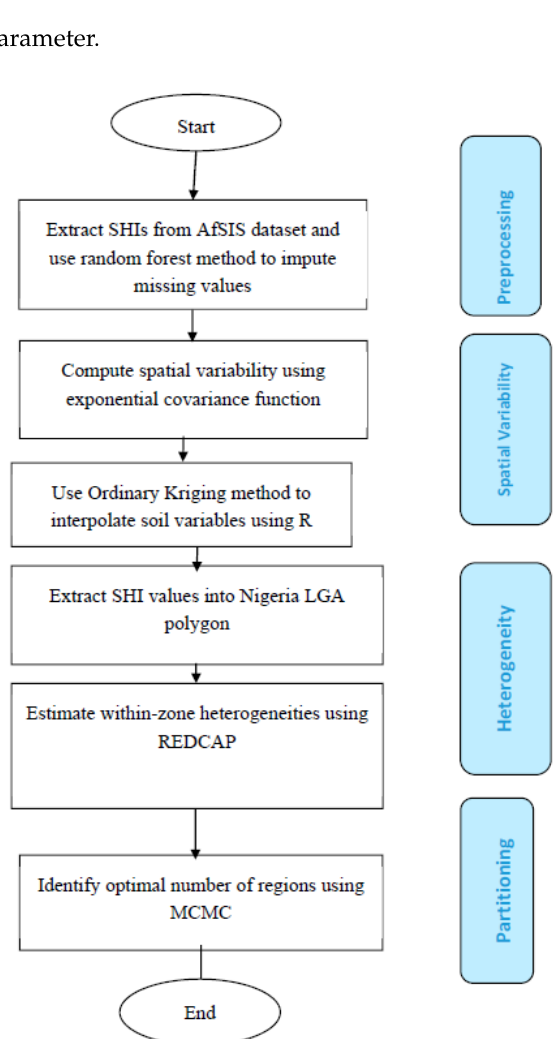
Figure 3. Flow chart of spatial variability and contiguous clustering of soil health indicators